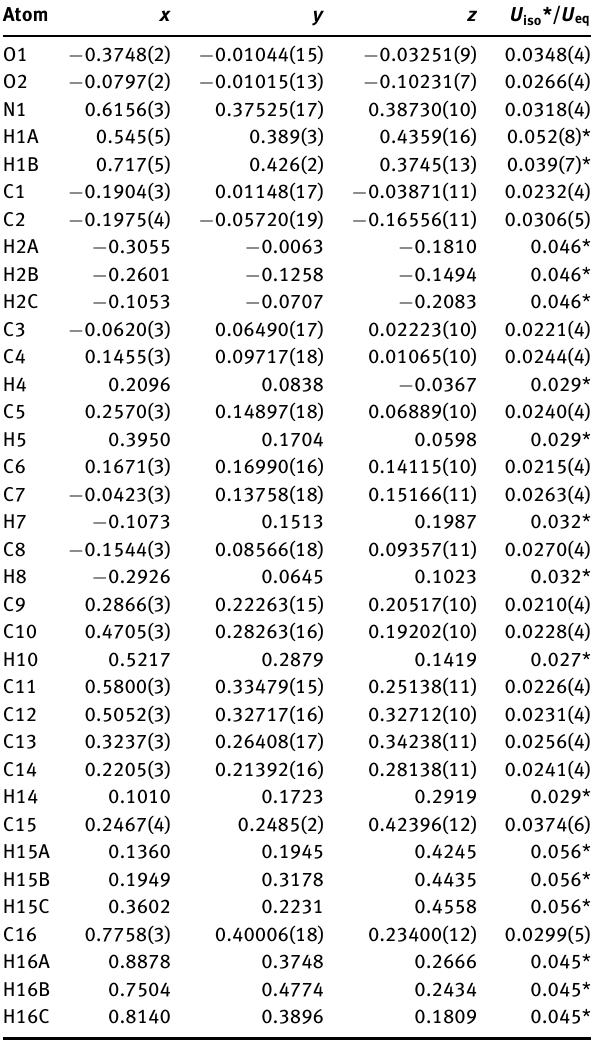
Table 2: Fractional atomic coordinates and isotropic or equivalent isotropic displacement parameters (Å 2